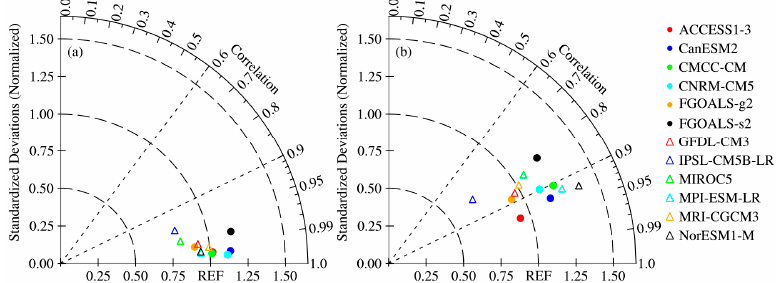
Figure 4. Taylor diagrams of ( a ) the climatological mean and ( b ) the interannual standard deviation of the geopotential height at 500 hPa over 25 ◦ –70 ◦ N, 100 ◦ –180 ◦ E in the boreal winter.